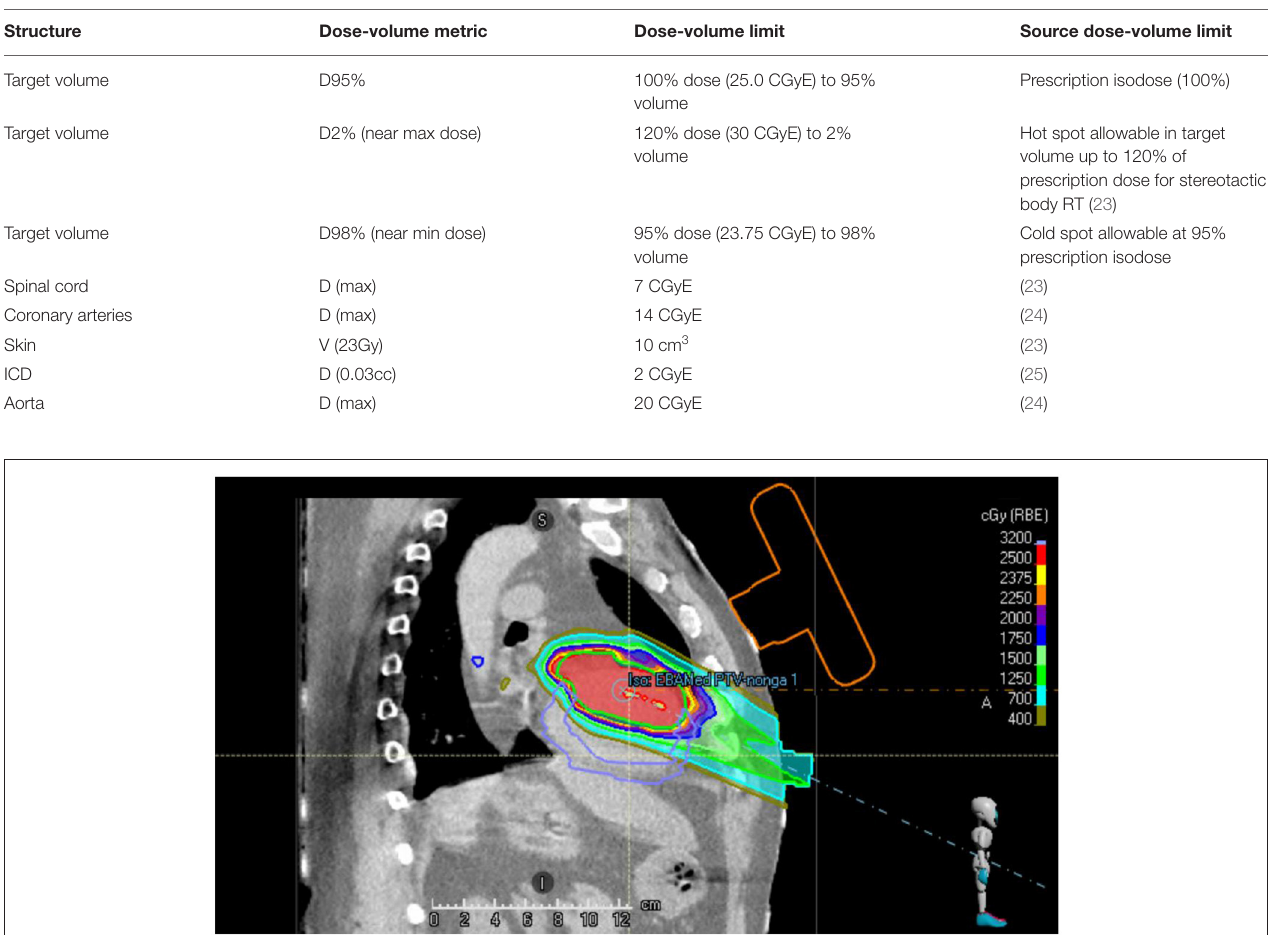
TABLE 1 | Evaluation metrics for a clinically acceptable plan (all constraints must be satisfied for a plan to be considered clinically acceptable). Structure